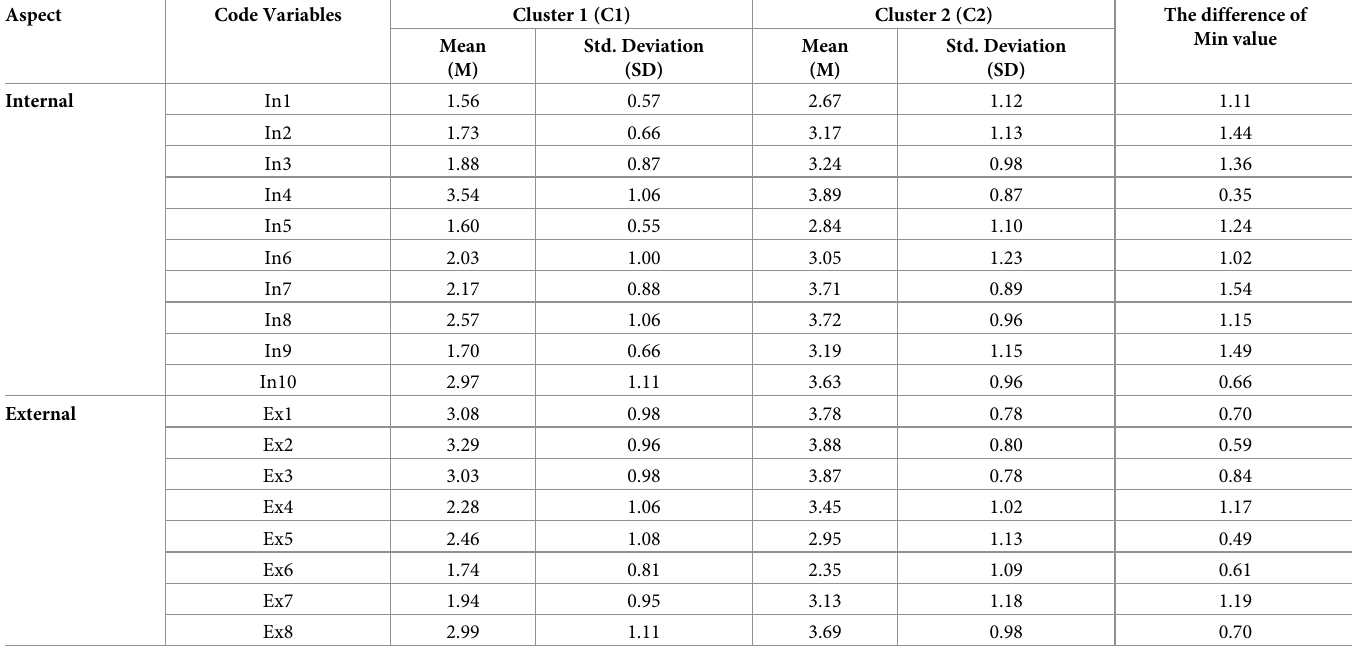
Table 5. Respondents’ perceptions toward PICK based on clusters. Aspect Code